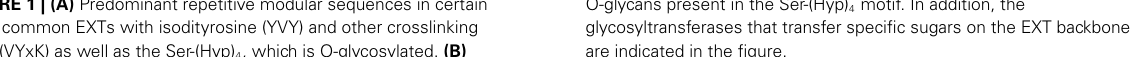
O-glycans present in the Ser-(Hyp) 4 motif. In addition, the glycosyltransferases that transfer specific sugars on the EXT backbone are indicated in the